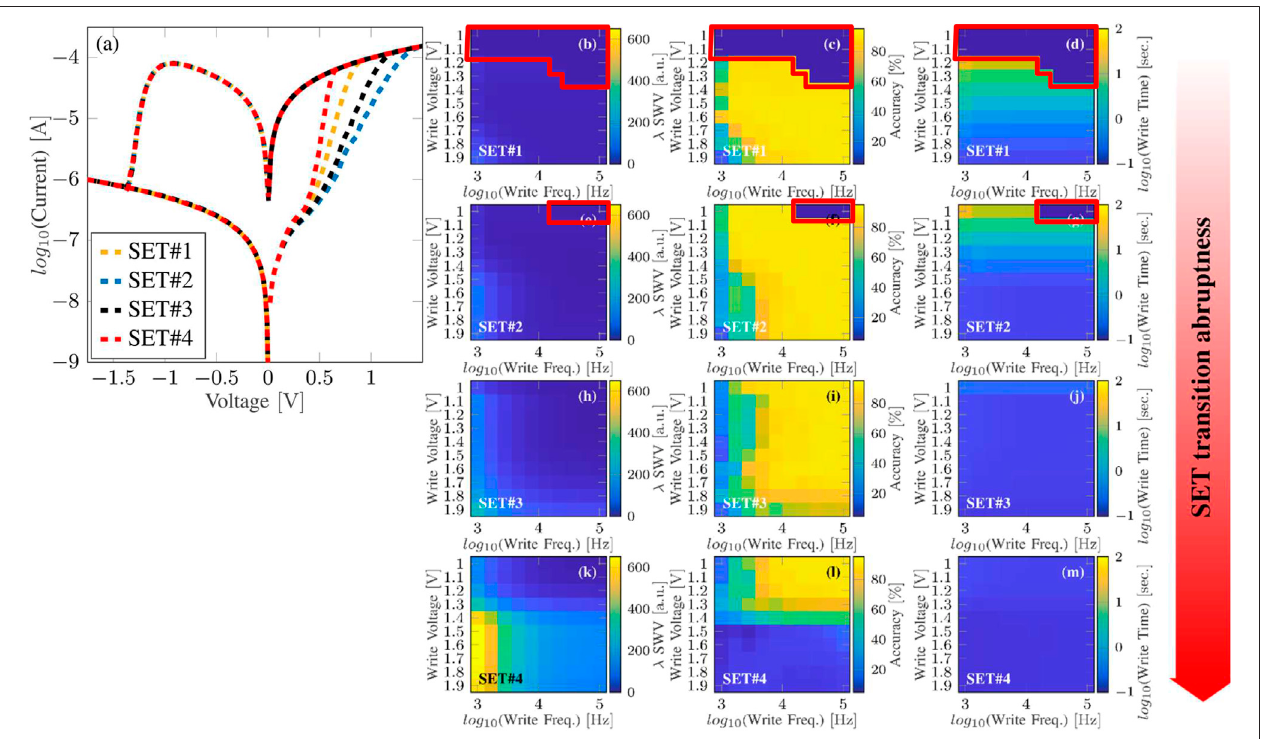
FIGURE8| SimulationresultsforthesynapticweightswritingprocessintothepartitionedCPA-basedSLPasafunctionofboththepulsesamplitudeandfrequency. (A) VariousmodelplaysoftheDMMareconsidered,comprising4differentSETabruptness. (B),(E),(H)and(K) showthetotalwritetime. (C),(F),(I)and(L) showthe λ -SWV. Finally (D),(G),(J) and (M) indicatethe inferenceaccuracyobtainedwiththe written SLP.Inall cases,the NM-1 was consideredand R L was set to10 Ω . Markedregions in (B – G) indicatesthecombinationsofwritefrequency-writevoltagethatrendersexcessivelylongprogrammingtimesandcannotcompletetheentireCPAprogramming.